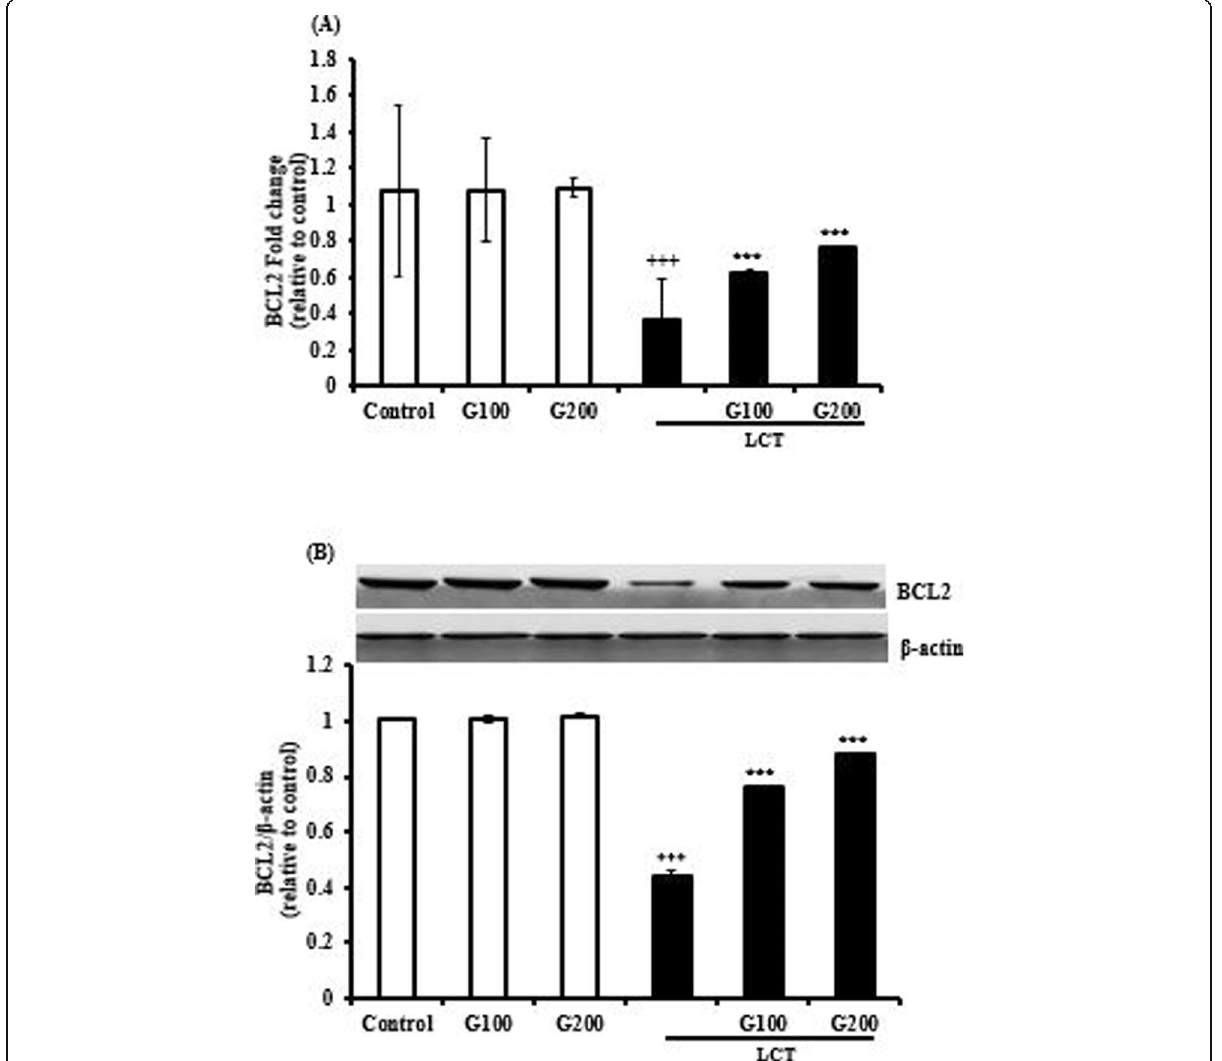
Fig. 5 Liver a BCL2 mRNA and b BCL2 protein expression levels in control, G, LCT, and LCT rats co-treated with G. The results were expressed as mean ± SE ( N = 6). Where C, control group; G, Panax ginseng injected rats; and LCT, lambda cyhalotherin administered rats. Values were considered significantly different +++ P < 0.001 versus control group and *** P < 0.001versus LCT